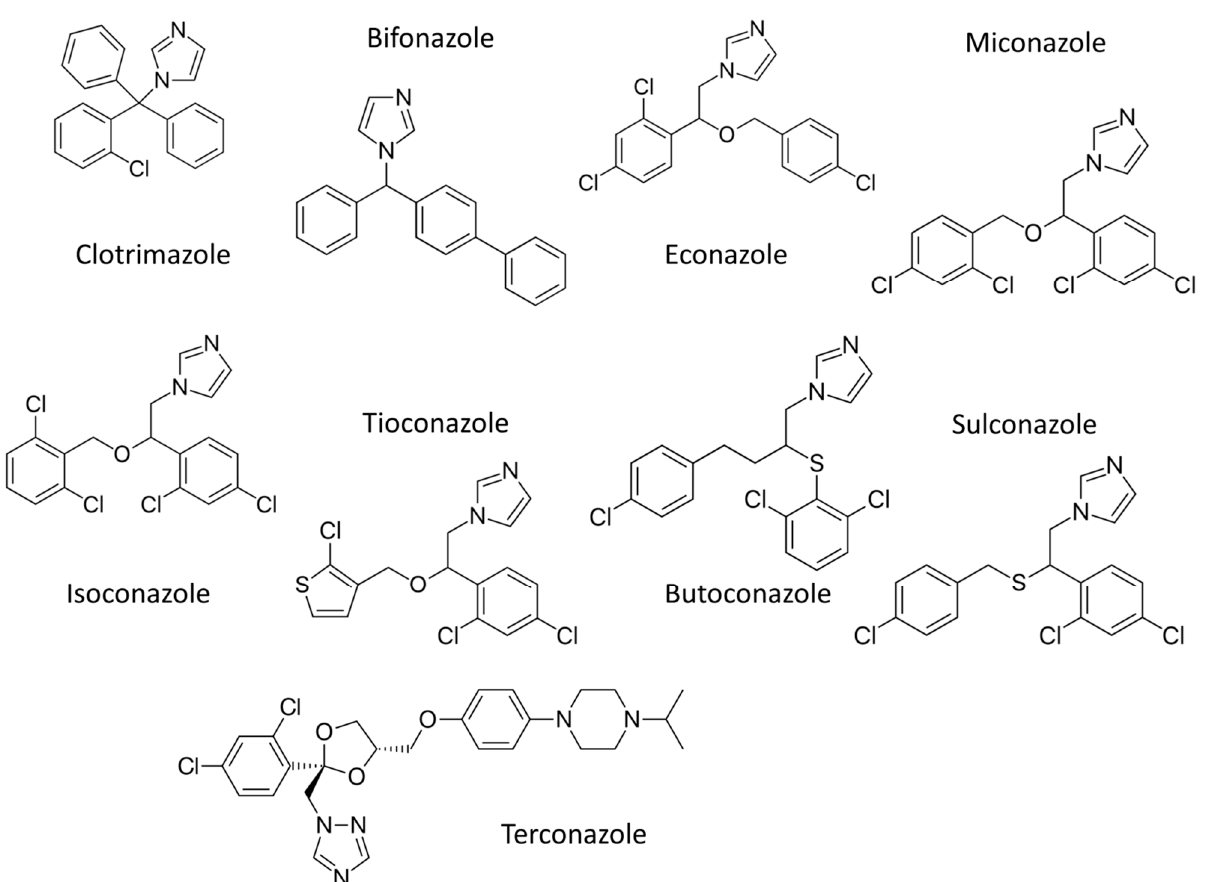
Figure 2. Chemical structures of antifungal azoles for topical applications. Clotrimazole is an imidazole antifungal drug with a broad spectrum of action and is one of the most widely used antifungals. In smaller doses, it has fungistatic and in higher doses fungicidal action on Candida albicans , Trichophyton rubrum , Trichophyton mentagrophytes , Epidermophyton floccosum , Microsporum canis, and Malassezia furfur [17]. Side effects and limitations of use: Clotrimazole preparations should not come into contact with mucous membranes, nor should the patient expose the treated area to the sun. Irritation, burning, rash, itching, peeling, or skin edema may rarely occur at the site of use [17]. Miconazole is an imidazole derivative that has a fungicidal effect especially on dermatomycetes and Candida . It is intended for the treatment of skin infections caused by fungi of the genus Candida , treatment of tinea pedis (athletic foot), tinea cruris and tinea corporis caused by Trichophyton rubrum and Trichophyton mentagrophytes . It is also used to treat Pityrosporum orbiculare ( Malassezia furfur ) [18]. Side effects and limitations of use: It cannot be used in the form of tablets or cap- sules because it is not absorbed enough from the digestive tract. If it is given parenteral- ly (by injection), it may cause many side effects, and thus it can only be given in emer- gency and life-threatening situations. When using miconazole in the form of a cream, sporadic cases of maceration, allergic dermatitis, irritation, and redness of the skin have been described [18]. Ketoconazole, an imidazole derivative, is a broad-spectrum antifungal agent. It acts on dermatomycetes ( Microsporum , Trichophyton , and Epidermophyton ), yeasts ( Candida , Cryptococcus , Torulopsis , and Pityrosporum ), dimorphic fungi ( Histoplasma capsulatum , Coccidioides , and Paracoccidioides ), and eumycetes. It comes in the form of creams, sham-